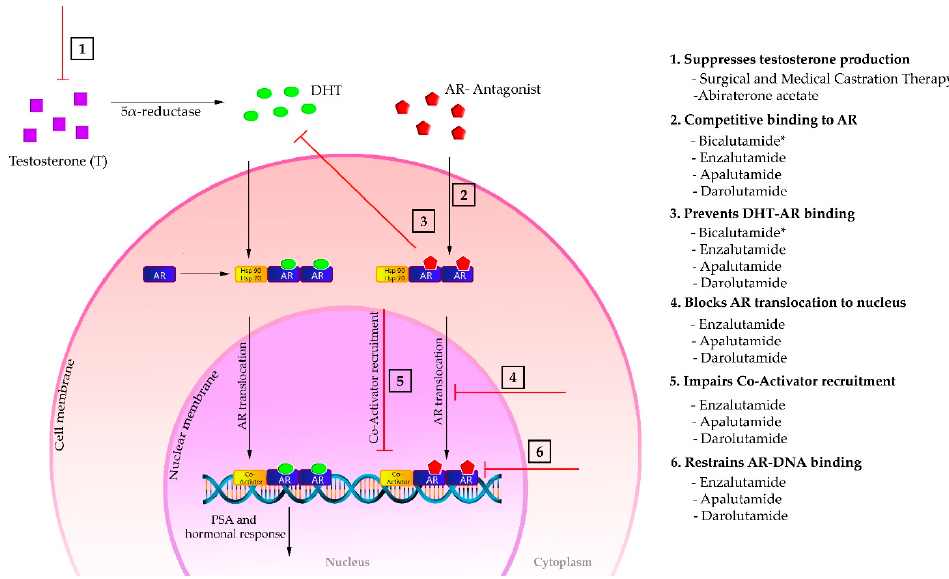
Figure 5. Mechanism of action of different hormonal therapies in AR signaling pathway. * First generation nonsteroidal AR antagonist.